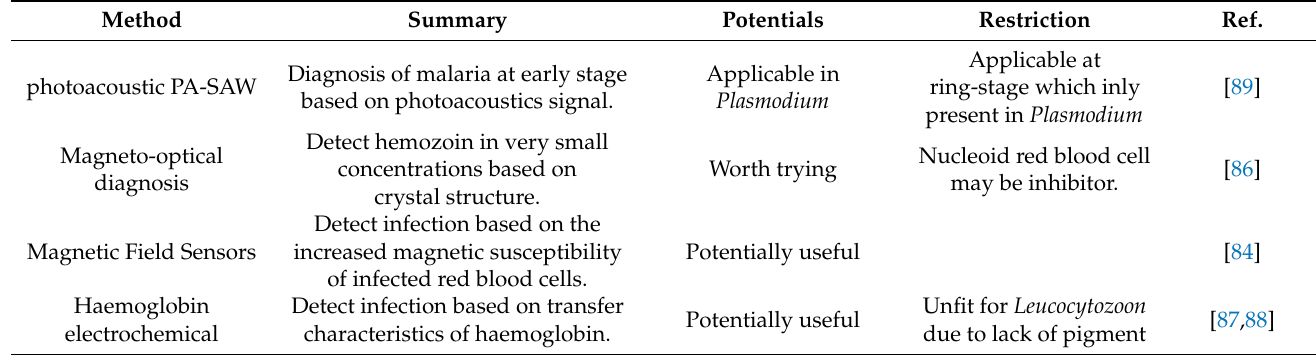
Table 1. Emerging technologies in other parasites and their potential for studying avian haemosporidian parasites. Method